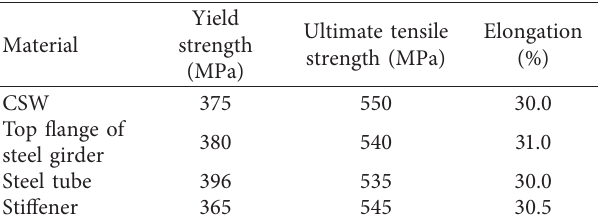
Figure 2: Design of the test specimen. (a) Dimensions and geometry of beam. (b) Sections A-A and B-B. (c) Details of corrugation profile. Table 1: Material properties of